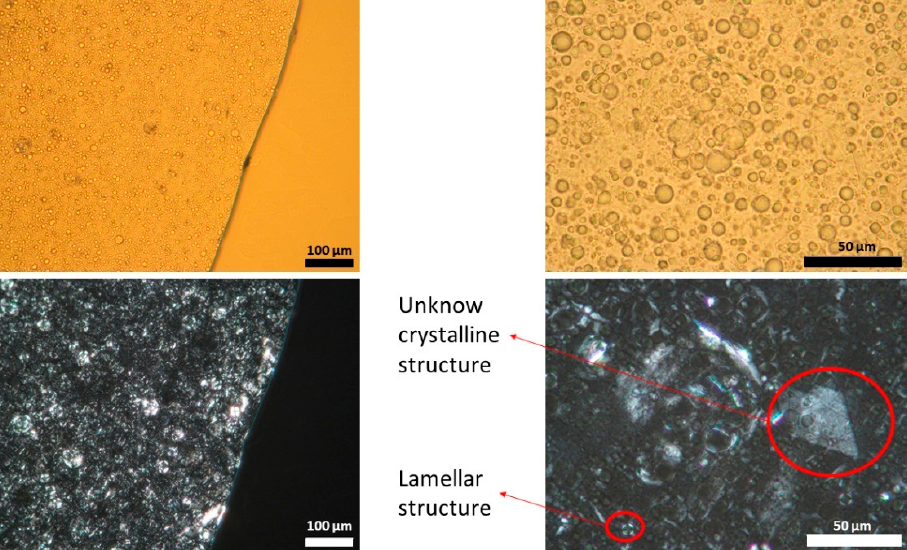
Figure 1. Light (upper panel) and polarized (lower panel) microscope images of batch one capsaicin emulsion at different magnifications. Unknown crystalline structure and lamellar structure is highlighted. A high variability in droplet size could be observed.